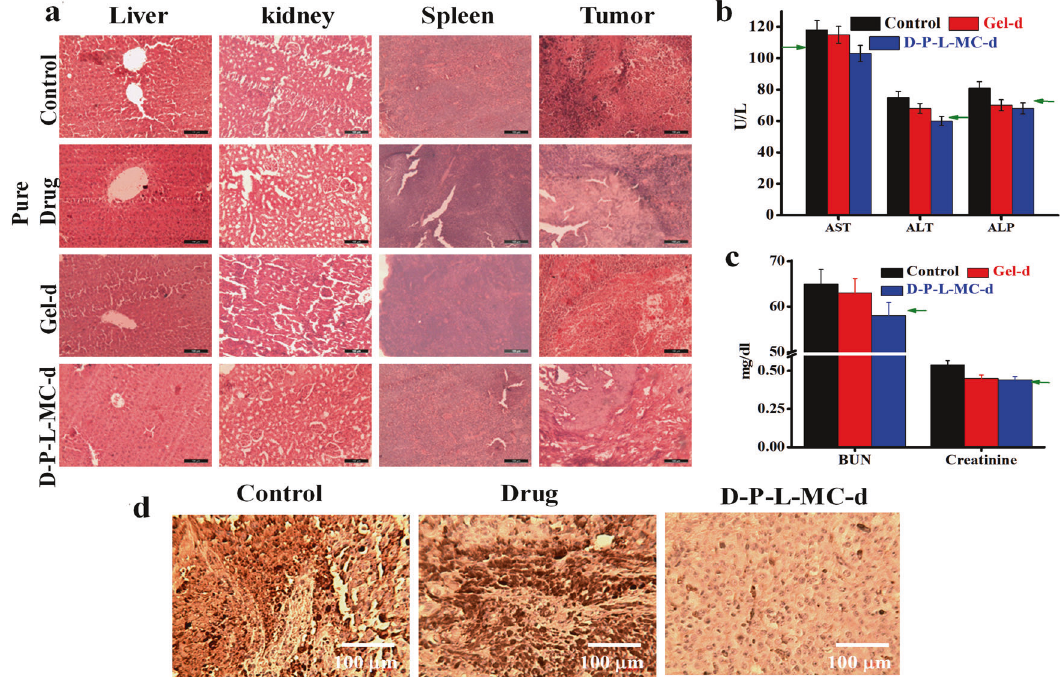
Fig. 7 Effect of in vivo controlled drug release and its underlying effects on organs and melanoma tumor. a Histopathological analysis of important organs like liver, kidney, spleen, and tumor dissected from mice after 30 days of treatment using H&E staining, at magni fi cation of 10x. b Liver function tests by estimating the serum levels of AST, ALT, and ALP across treatment groups. c Renal function test by measuring the serum level of BUN and creatinine across the various treatment groups. Corresponding values of healthy mice are indicated by the arrows. d Immunihistochemistry of tumor tissues at the end of treatment regimen using melanoma inhibitory activity (MIA)